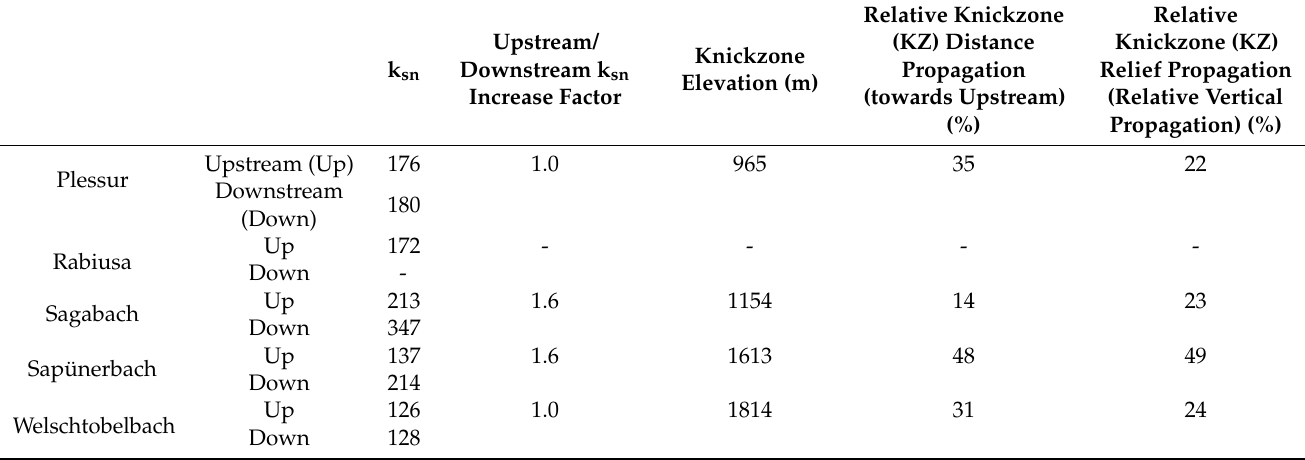
Table 1. Normalized steepness index of the Plessur River and main tributaries and their upriver propagation.